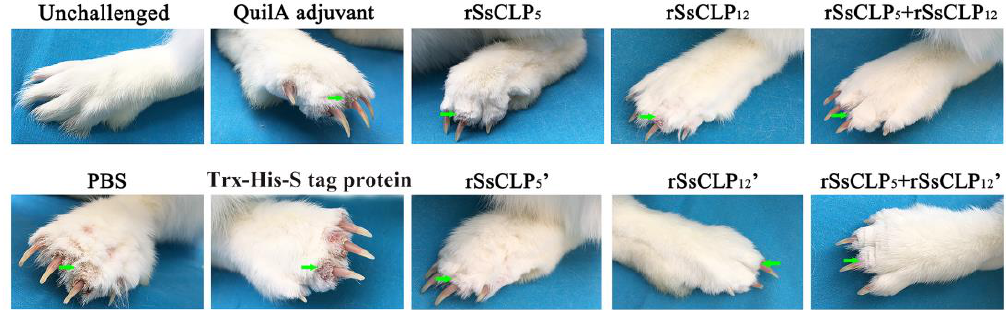
Figure 2. Clinical symptoms in rabbits after mite challenge for four weeks. unchallenged, the rabbits